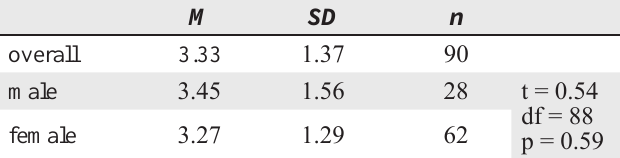
Table 2 : Mean of social support score